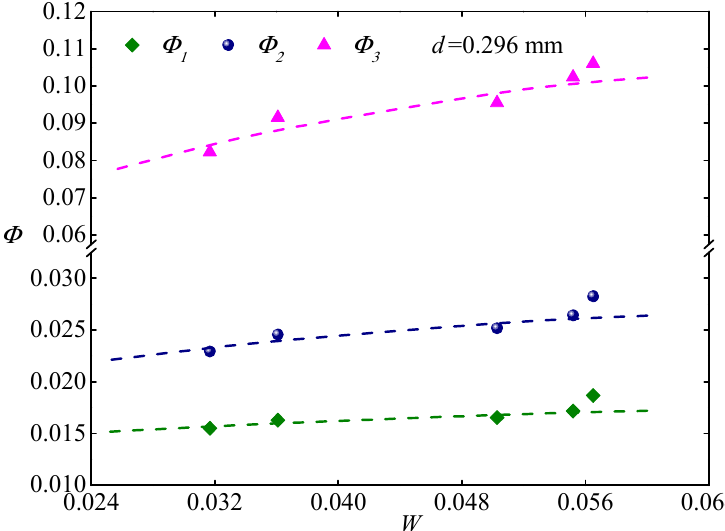
Figure 8. Relationship between unsteady parameters and sediment transport intensity parameters.